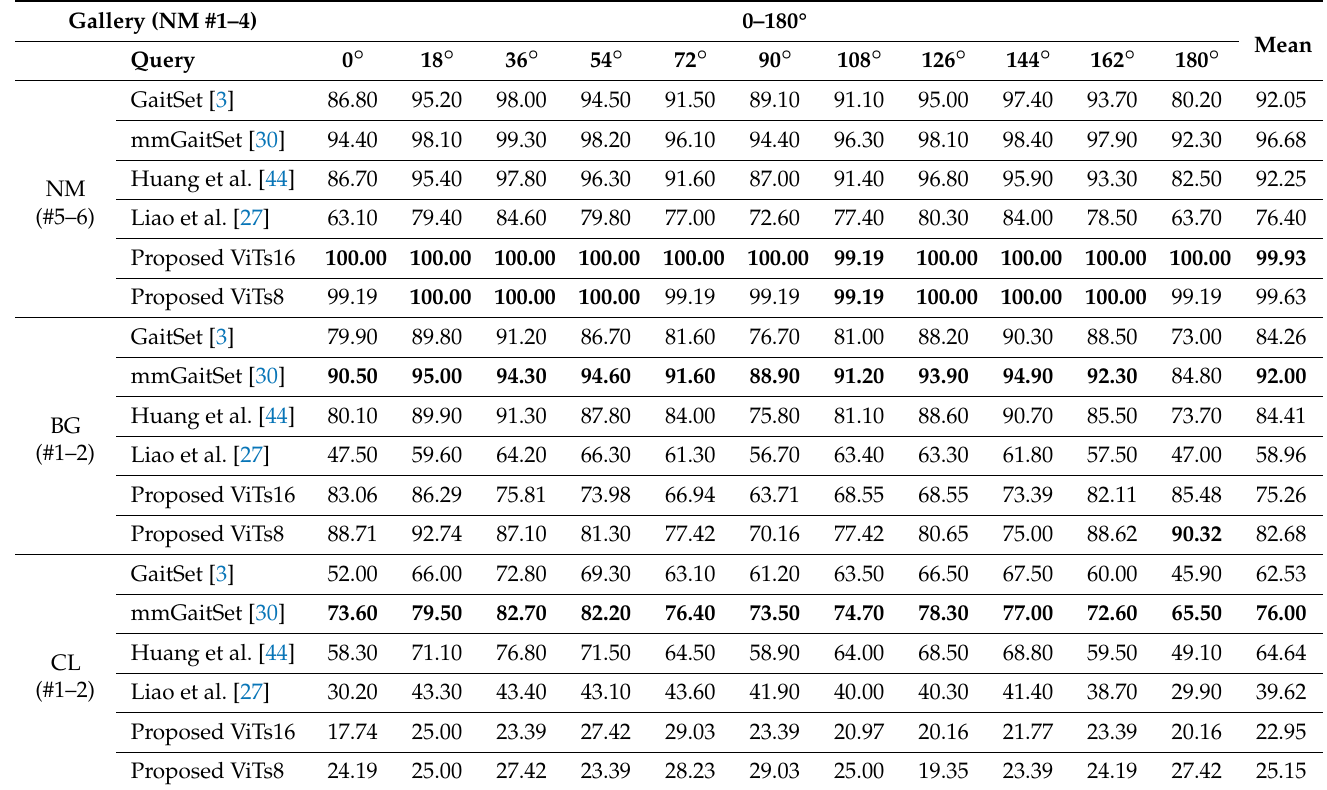
Table 2. Results for CASIA-B dataset MT setting. The best results for each angle and overall are in